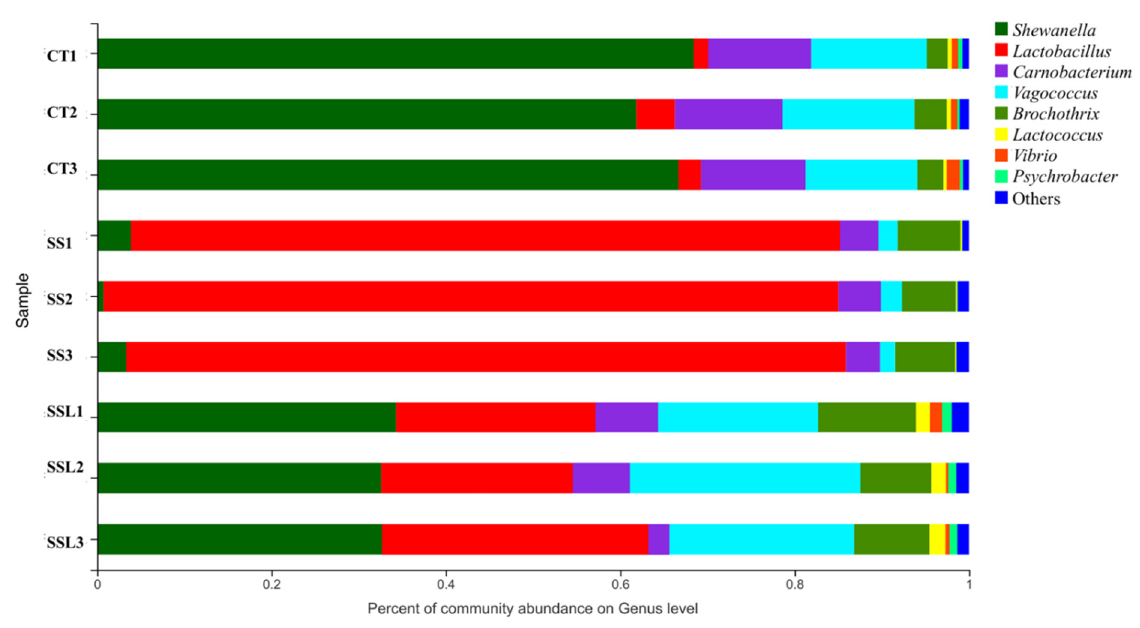
Figure 6. Bacterial community composition.